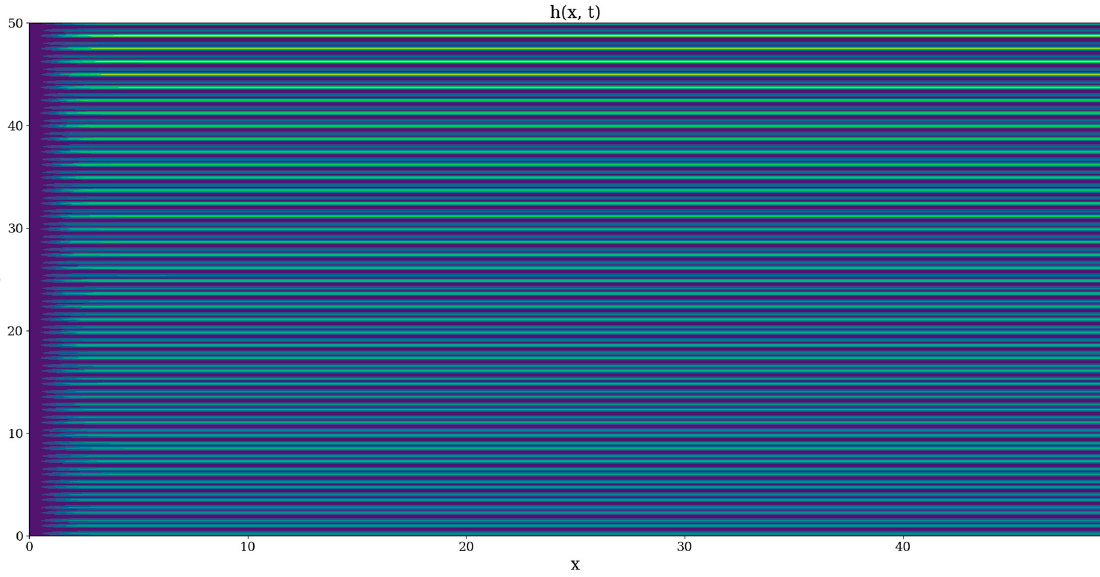
Figure 2. Example plot of h(x,t) ; ω constant odd integer.